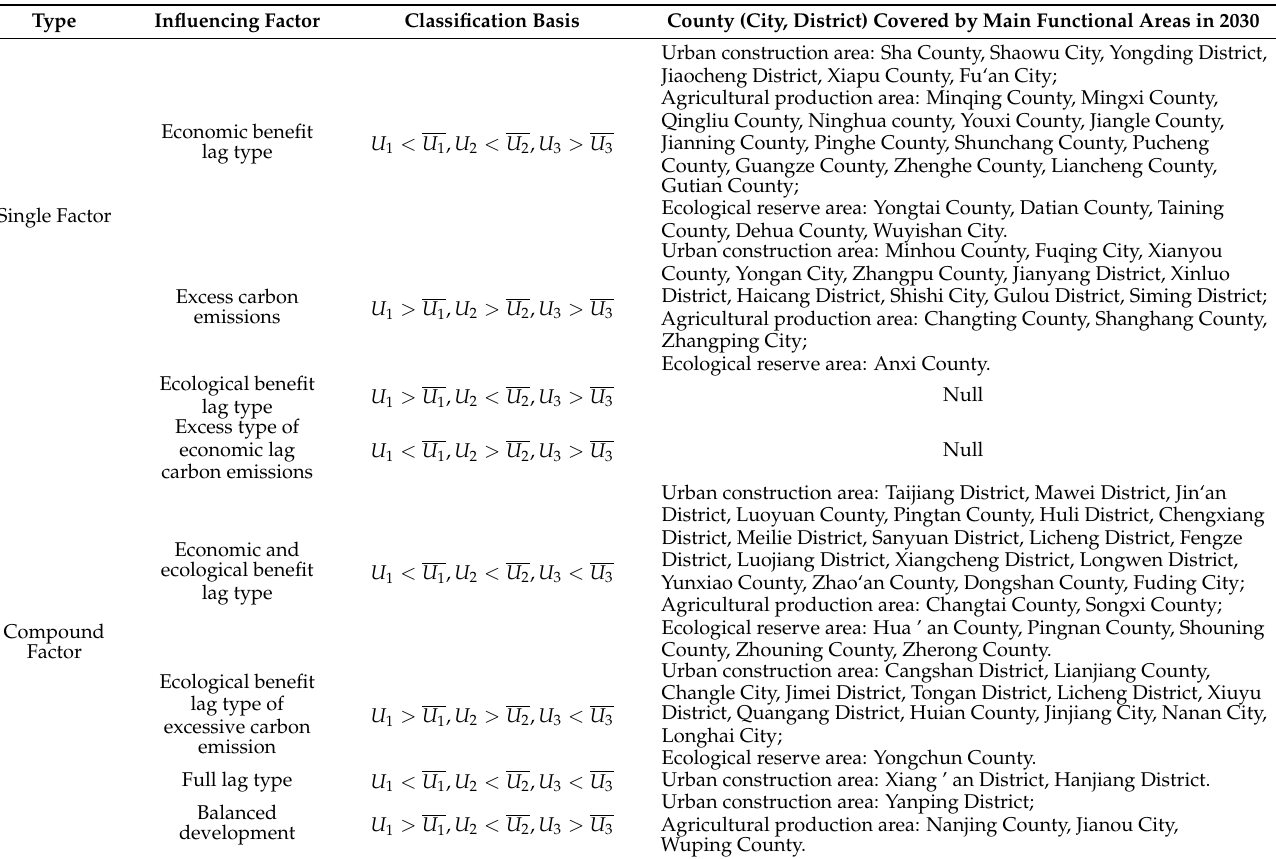
Table 11. Classification of restrictive factors of land use efficiency coupling coordination relationship in Fujian